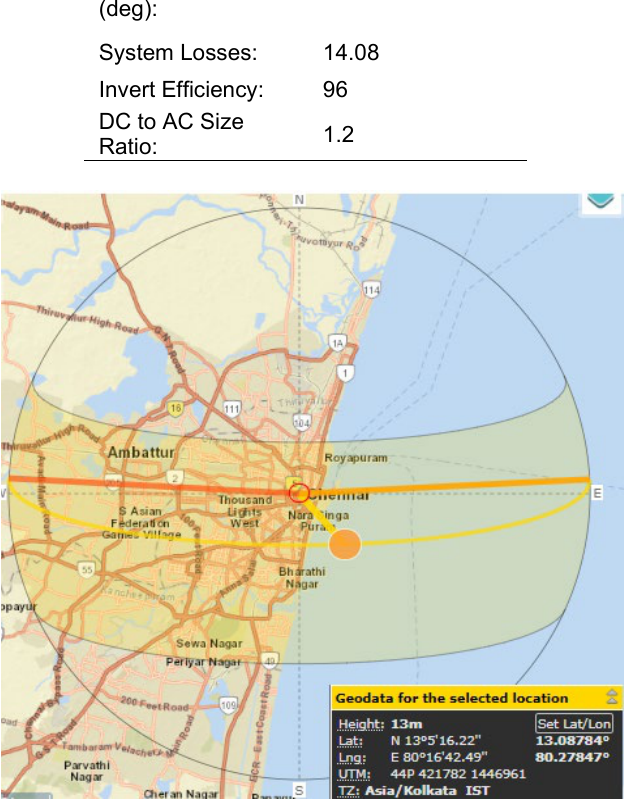
Figure 1. Sun path from